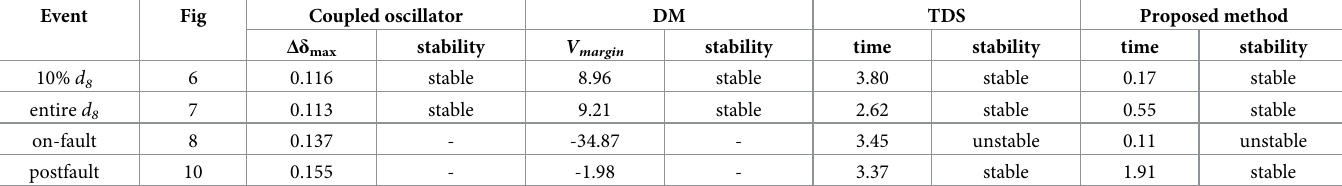
Table 2. Summary of the simulation results.